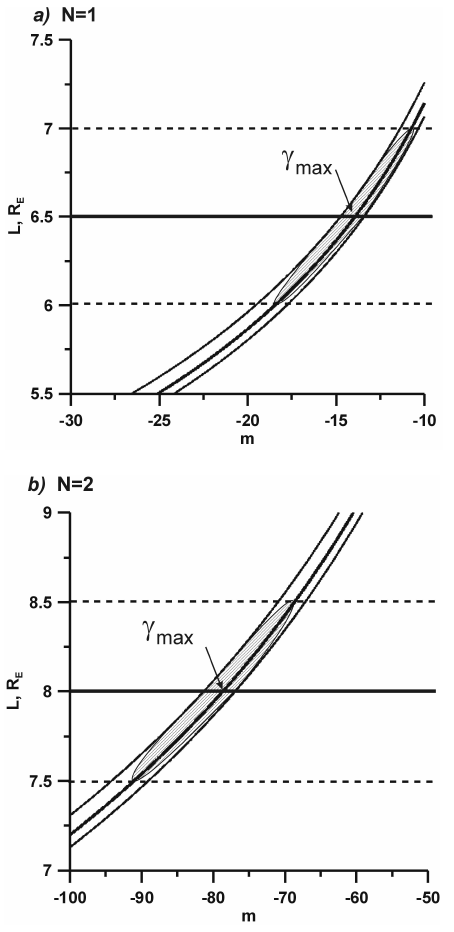
takes place when these two factors select the same L shells. For the particles with energies (cid:15) ∼ 10 keV and waves with